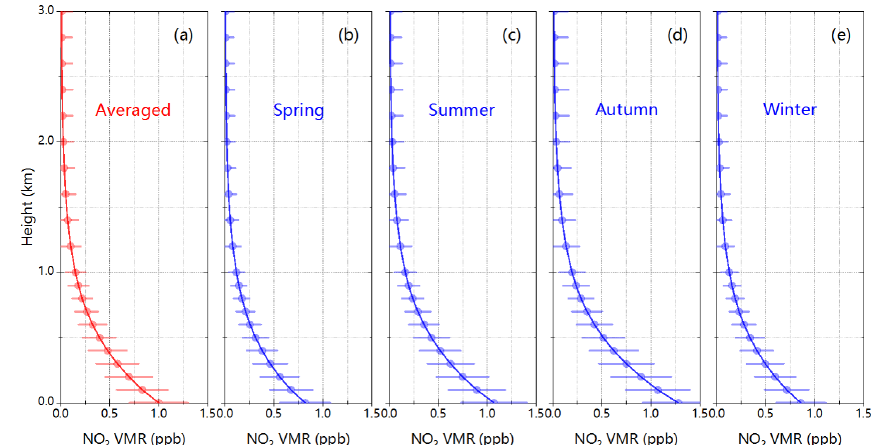
Figure 9. (a) Total-averaged, (b) spring-averaged, (c) summer-averaged, (d) autumn-averaged and (e) winter-averaged NO 2 vertical profiles from December 2017 to February 2019 at CAS (QOMS).